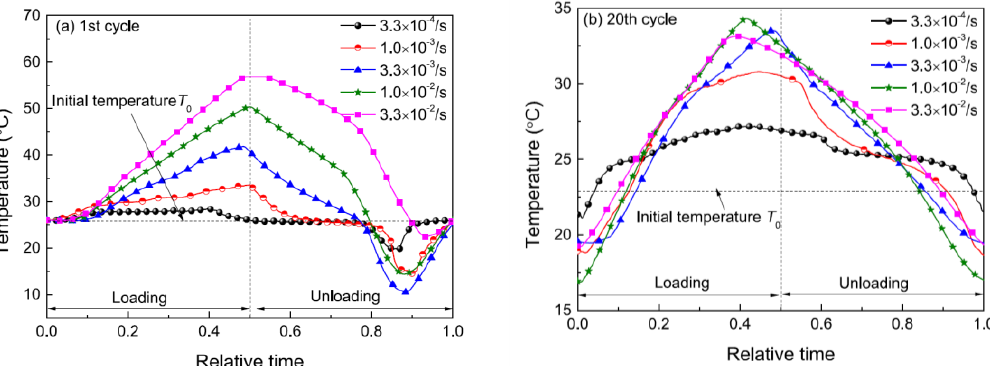
Figure 9. Temperature records at various strain rates in the 1st cycle ( left ) and 20th cycle ( right ) [37]. (Reprinted from Ref. [37], Fig. 9, 2016, with permission from Elsevier.)